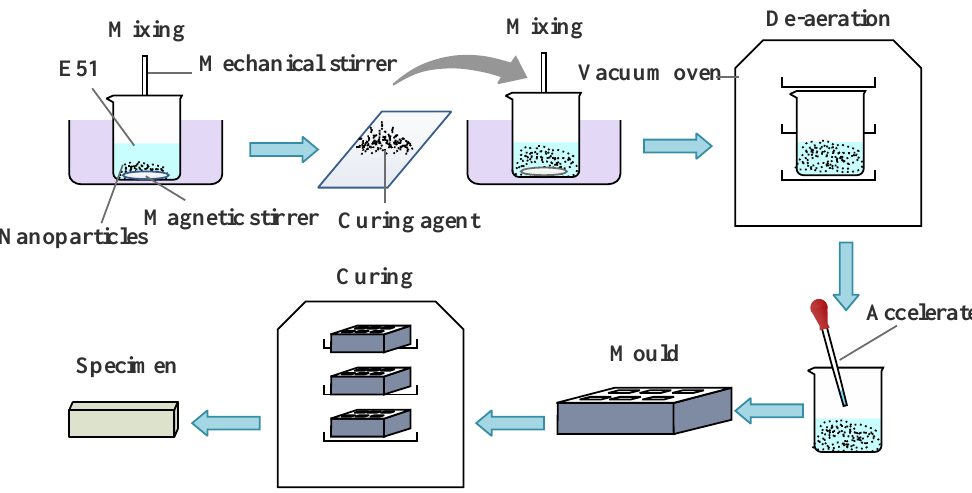
Figure 1. The process of specimens manufacturing.